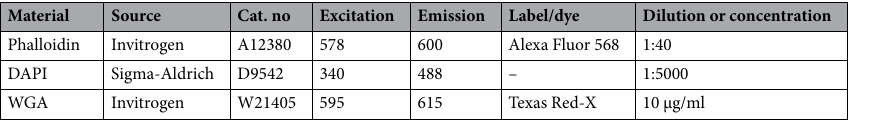
Table 6. List of Immunofluorescent stains